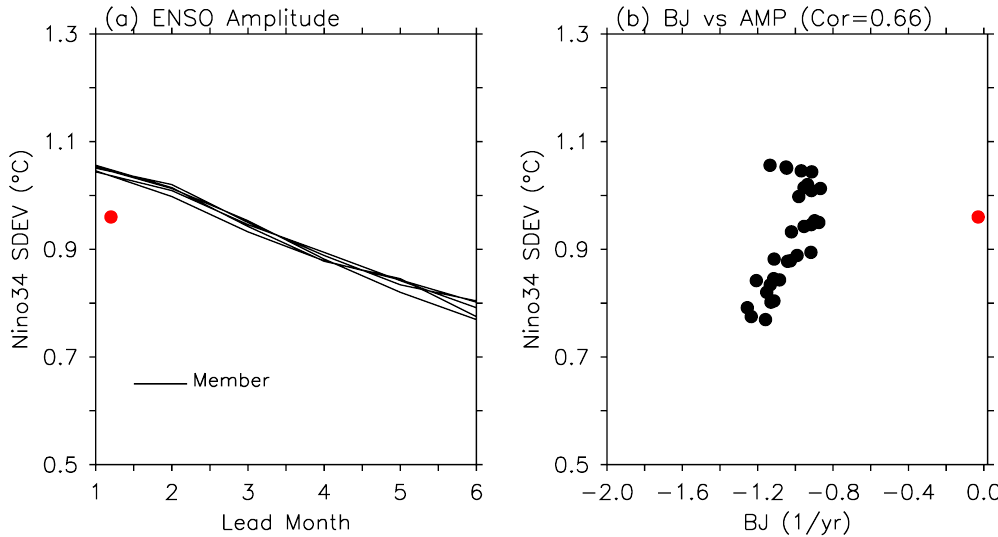
Figure 2. Error in ENSO amplitude forecasts. ( a ) ENSO amplitude (°C) and ( b ) scatter plots of ENSO amplitude versus BJ index from 1- to 6-month lead times. Black lines and black dots correspond to individual forecasts. Red dots indicate observations. In ( b ), a correlation coefficient between BJ index and ENSO amplitude from individual forecasts is